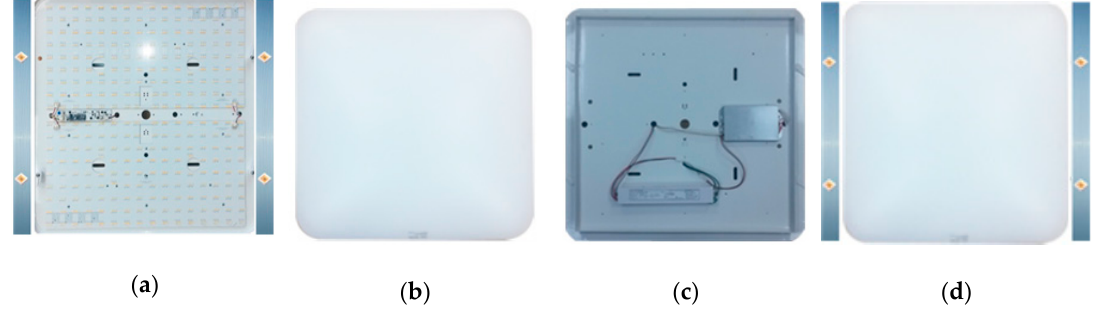
Figure 4. General lighting of indoor UVB LEDs. ( a ) vis and UVB LED array; ( b ) diffusion plate; ( c ) control & power; ( d ) front (apply diffusion plate).